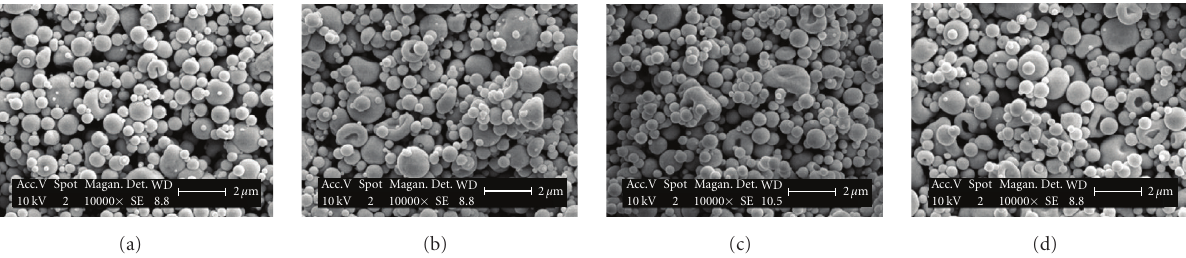
Figure 6: SEM images of NaTaO 3 powders synthesized by spray pyrolysis with variation of spray pyrolysis temperature: (a) 973 K, (b) 1073K, (c) 1173 K, (d) 1273 K (mean residence time = 1.80 seconds, precursor preparation temperature = 333K, precursor concentration = 0.125 M, carrier gas (air) flow rate = 5 L/min, Na/Ta = 1.00).